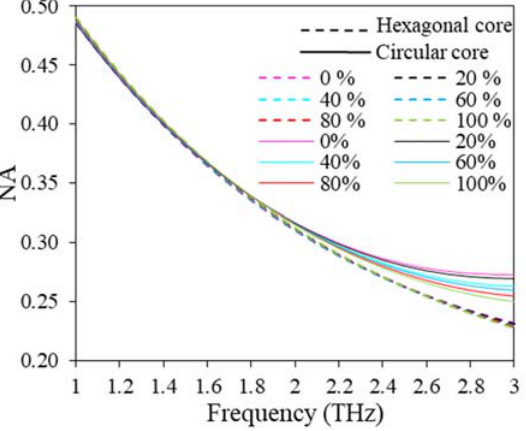
Figure 13. NA variation with the change of frequency for D = 643.34 μ m, D c = 280 μ m, t = 15 μ m, z = 10 μ m .